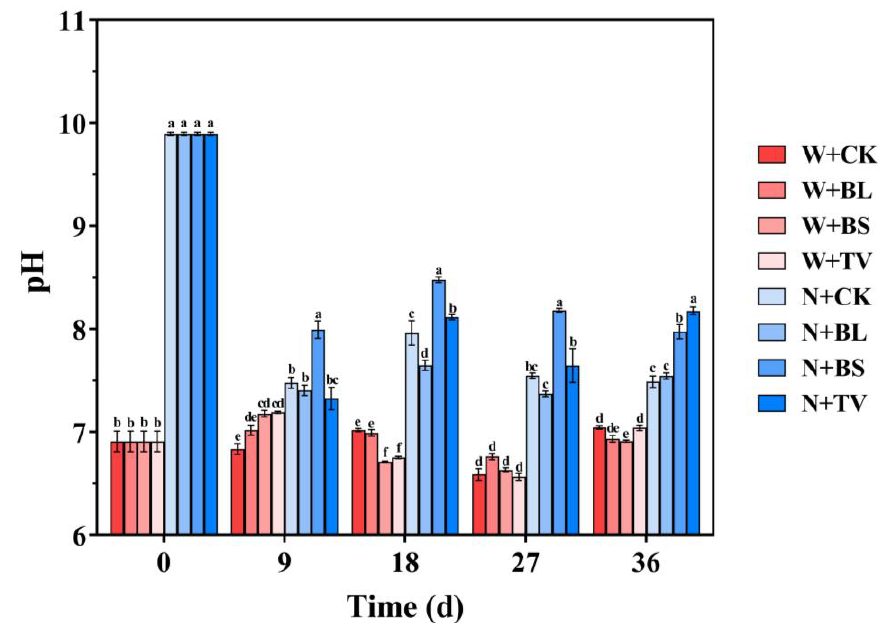
Figure 2. Changes in pH values in the treatments. Means ± SEs with different letters in each param- eter indicate significant statistical differences ( p < 0.05).